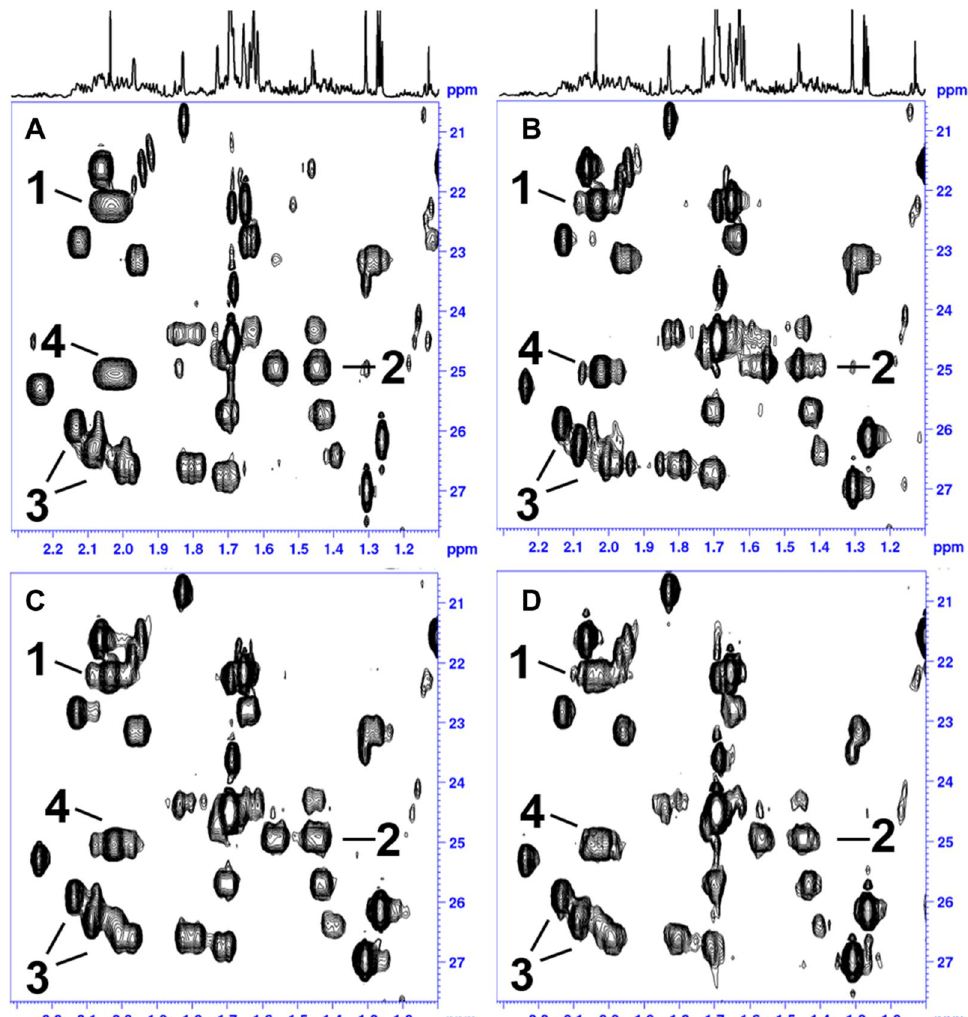
Figure 5. The spectra were collected on a Cannabis Terpene Mix solution in deuterated methanol. Detailed information on sample composition and experimental parameters is given in figure caption 4. This figure presents additional expansions of the sample mixture, in ( A ) a standard HSQC with no homodecoupling is shown, ( B ) displays the literature known HD HSQC with BIRD d element using the pulse sequence hsqcetgpsp.2_bbhd (Bruker release version), in ( C ) the result of restricted random HD 2D HSQC as described in text is presented and ( D ) shows the fully homodecoupled HSQC spectrum, where all multiplicities are reduced to singlet response. Diminished sidebands are clearly visible for the peaks annotated as 2 and 3. In ( B ), peaks denoted as 3 show significant sidebands in the 2D HD spectrum. While significant removal of sidebands is displayed in ( C , D